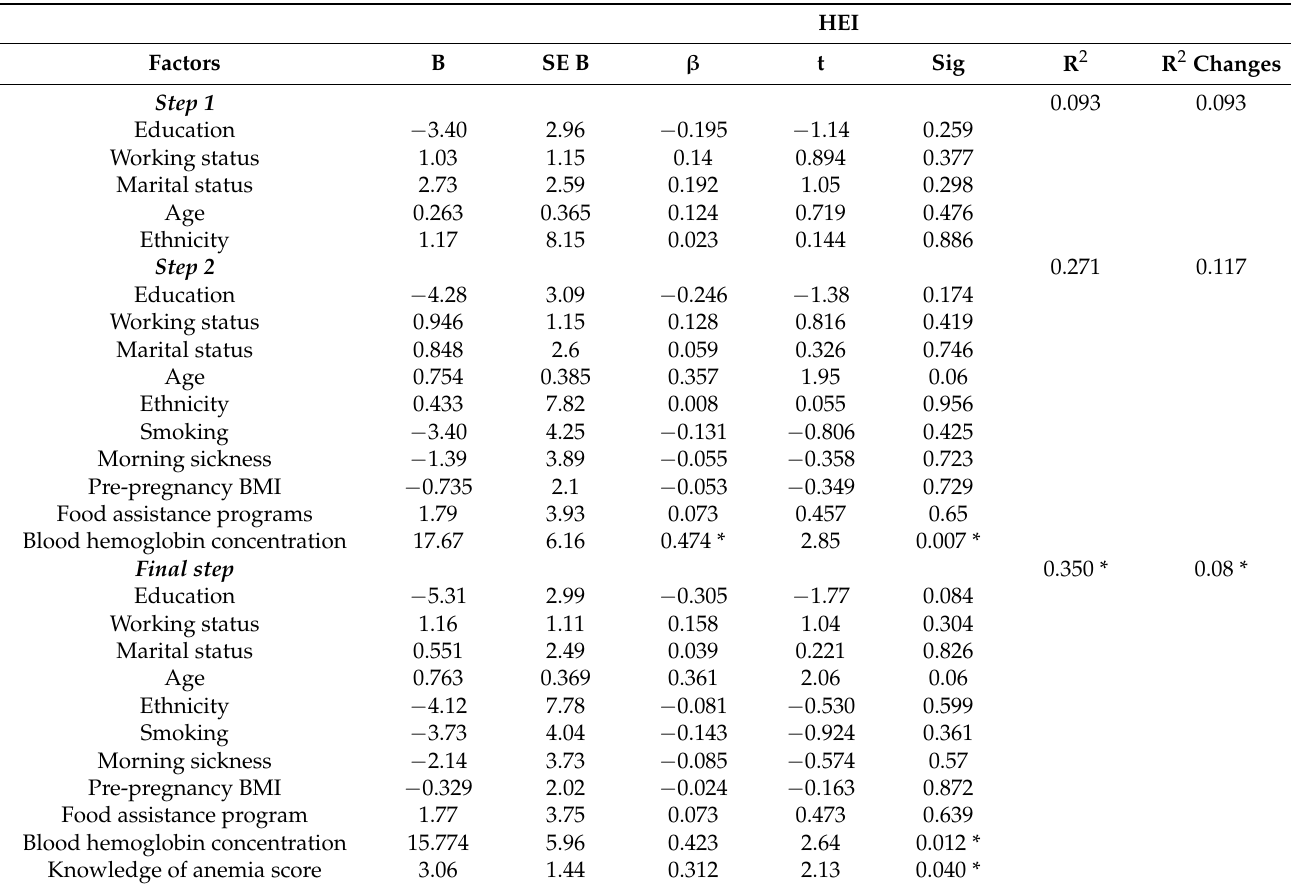
Table 9. Regression analysis predicting survey 2 HEI scores from maternal characteristics and nutritional